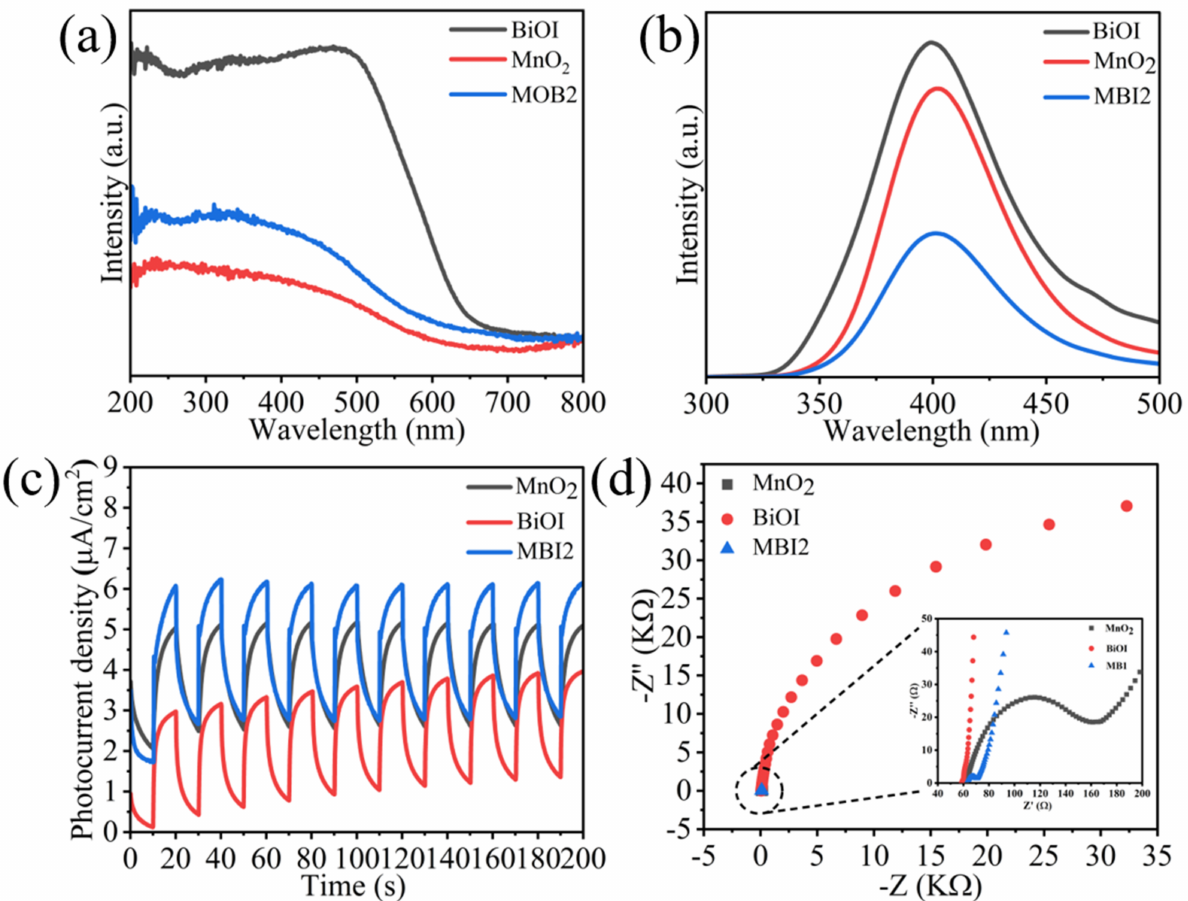
Figure 7. ( a ) UV–VIS absorption spectra; ( b ) PL spectra; ( c ) IT; and ( d ) EIS of pure α -MnO 2 , BiOI, and MBI2 composite